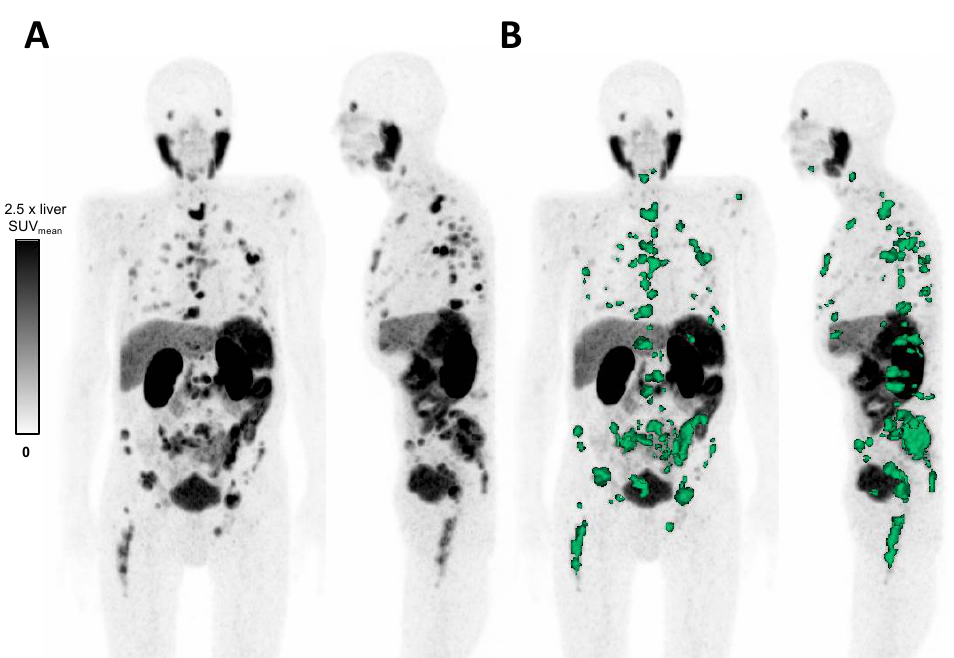
Figure 1. ( A ) MIP (maximum intensity projection) of [ 68 Ga]Ga-PSMA-11 PET in an advanced mCRPC patient. ( B ) Semi-automatic tumor segmentation by Syngo.via (Enterprise VB 60, Siemens, Erlangen, Germany). SUV windowing was set from 0 to 2.5 times SUV mean of the liver. The delineated tumor volume is shown in green.